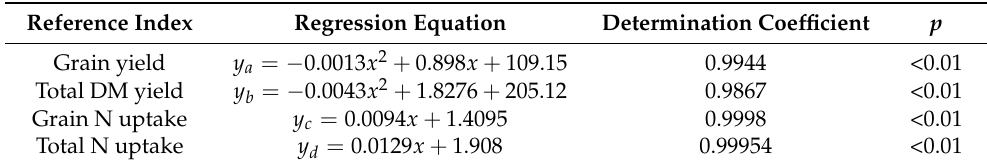
Table 4. Maize grain yield, total dry matter yield, grain N uptake and total N uptake in response to the mineral N application